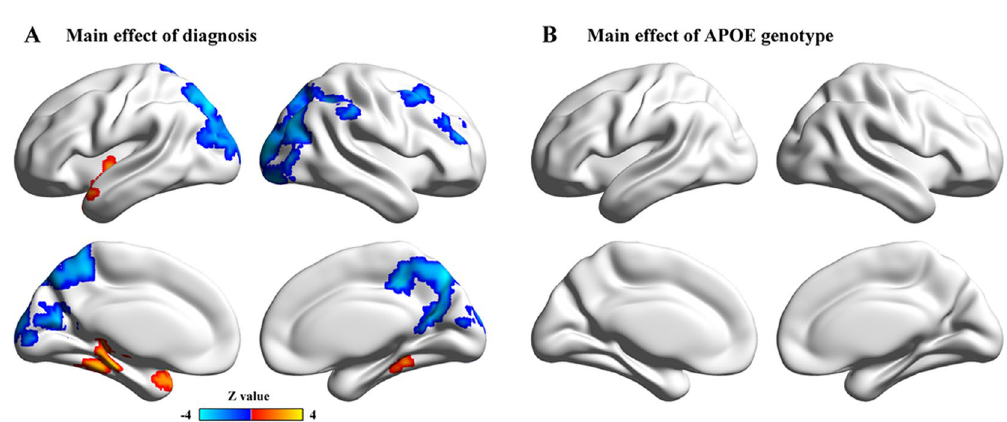
Figure 2. Main effect of diagnosis on EC. ( A ) Statistical map of the main effects of diagnosis. The statistical significance threshold was set at | z | > 1.96 ( P < 0.05), and cluster size > 4,266 mm 3 , which corresponded to a corrected P < 0.05. The color map shows significant differences in Z between the aMCI and HC groups. Warm colors represent higher EC values in the aMCI group compared with the HC group, while the cool colors represent the opposite. ( B ) Statistical map of the main effects of APOE genotype. There was no significant effect of APOE genotype on EC. EC, eigenvector centrality; HC, healthy control; and aMCI, amnestic mild cognitive